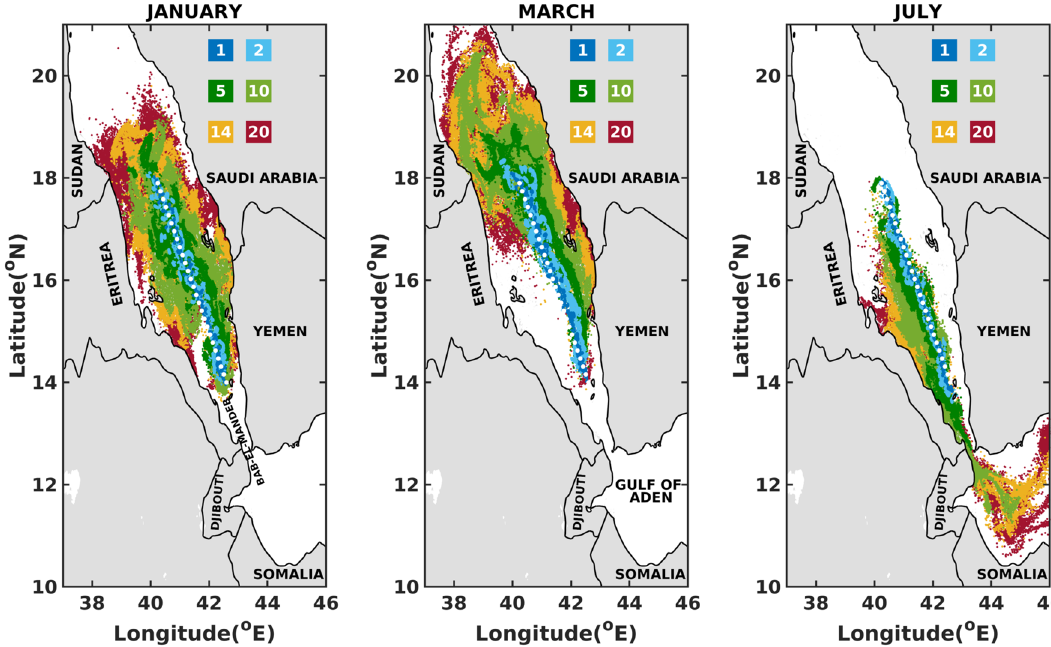
Figure 3. Superposition maps for the one (1), two (2), five (5), ten (10), fourteen (14) and twenty (20) days after the commencement of the spill, in the Southern Red Sea. The figures were created on Matlab-r2020b (https:// matlab- r2020b. softw are. infor mer.